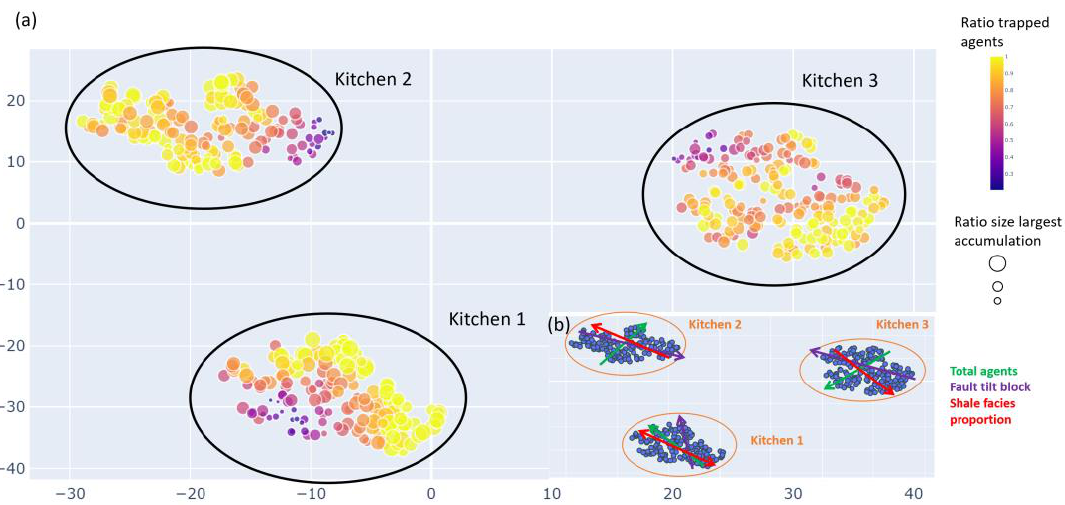
Figure 9. t-SNE visualisation showing the most impactful geological uncertainties and their corre- lation with simulation evaluation metrics. Each point represents an individual model from the Monte Carlo simulation. ( a ) The points are colour coded with the evaluation metric ratio of trapped agents and sized by the size of the most significant accumulation. ( b ) Display of the trends of the original geological parameters with colour coded arrows.